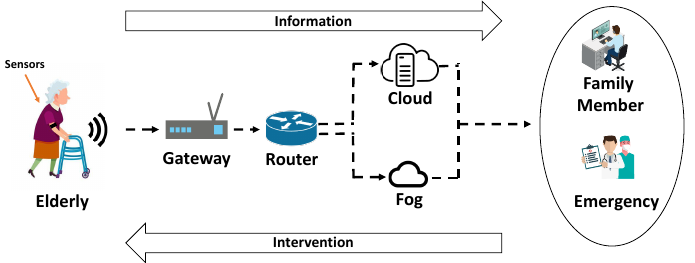
Figure 1. Scenario illustration of a health monitoring system for elderly